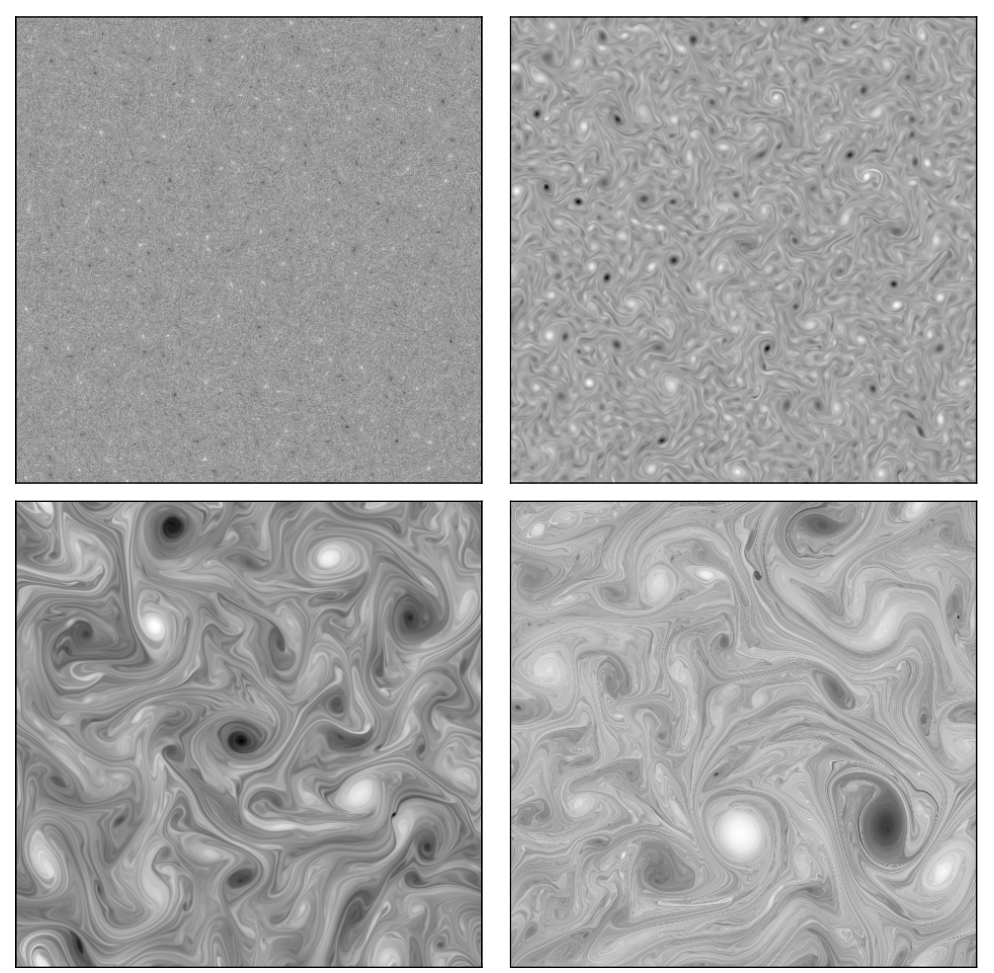
Figure 10 . Snapshots of vorticity. (Top left): conformal (cid:13)uid inverse-cascade with k f = 203 ( (cid:20) = 0 : 02 case). (Top right): conformal (cid:13)uid inverse cascade with k f = 42. (Bottom left): conformal (cid:13)uid direct cascade with k f = 7. (Bottom right): incompressible (cid:13)uid direct cascade with k f =